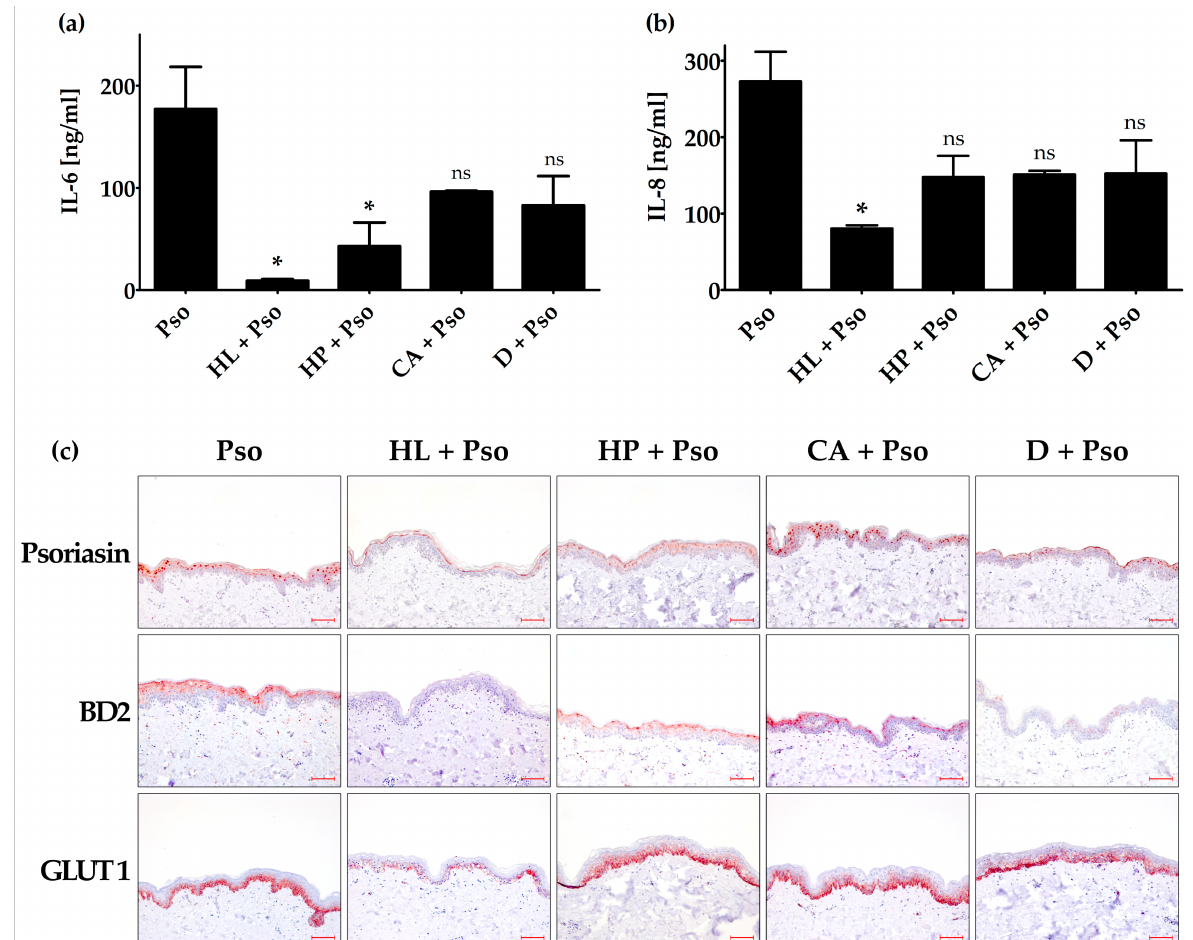
Figure 4. Effect of plant extracts in the ex vivo psoriasis model. The skin models were incubated with or without filter paper soaked with 40 µ L plant extract solution on top of the skin explants (1.5 µ g/mL HL ( Humulus lupulus ), 1.5 µ g/mL HP ( Hypericum perforatum ), 3 µ g/mL CA ( Curcuma amara ) or 0.4 µ g/mL D (dithranol) for 24 h and then stimulated with psoriasis cytokines (IL-17A, TNF- α and IL-22; 20 ng/mL each (Pso)) for 72 h. The protein level of secreted IL-6 ( a ) and IL-8 ( b ) was measured in the cell culture supernatant by ELISA ( n = 2). ( c ) Skin models were fixed, embedded in paraffin and 3 µ m sections were stained with antibodies against psoriasin (S100A7), β -defensin 2 (BD2), keratin 17 (KRT17) or glucose transporter 1 (GLUT1). Scale bar = 100 µ m. * p ≤ 0.05, ns-not significant ( p >